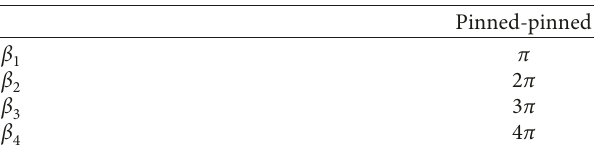
Table 1: Values of β .